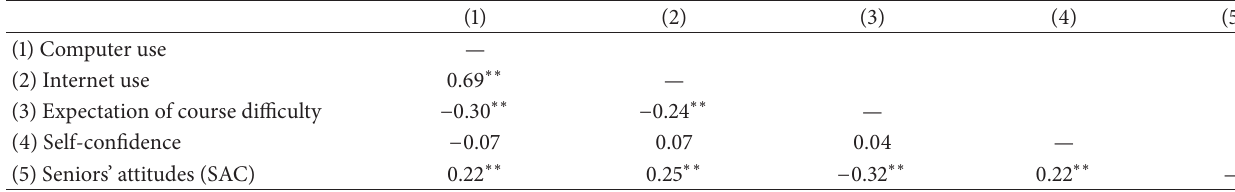
Table 2: Correlations between the different variables ( 𝑁 = 191